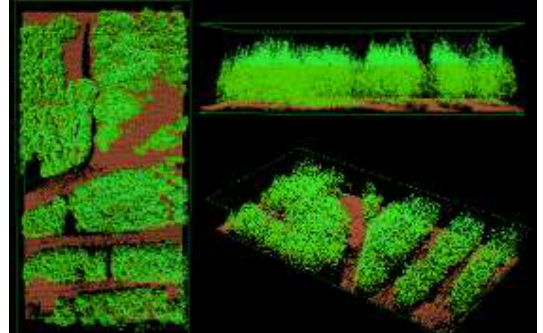
Figure 2. Point cloud data are classified as ground and